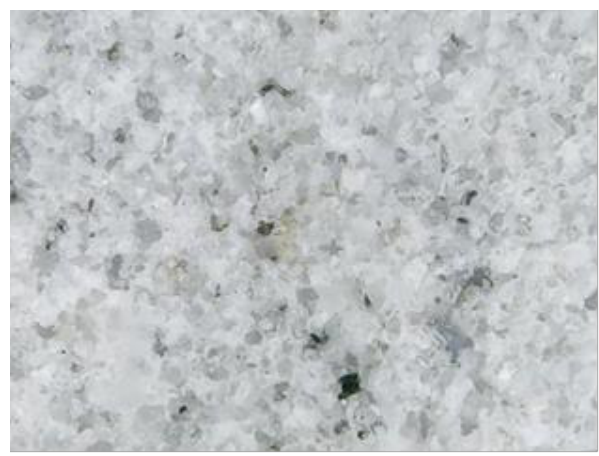
Figure 7. S4 sample series; magnification 500 X. Table 2. Chemical composition of the